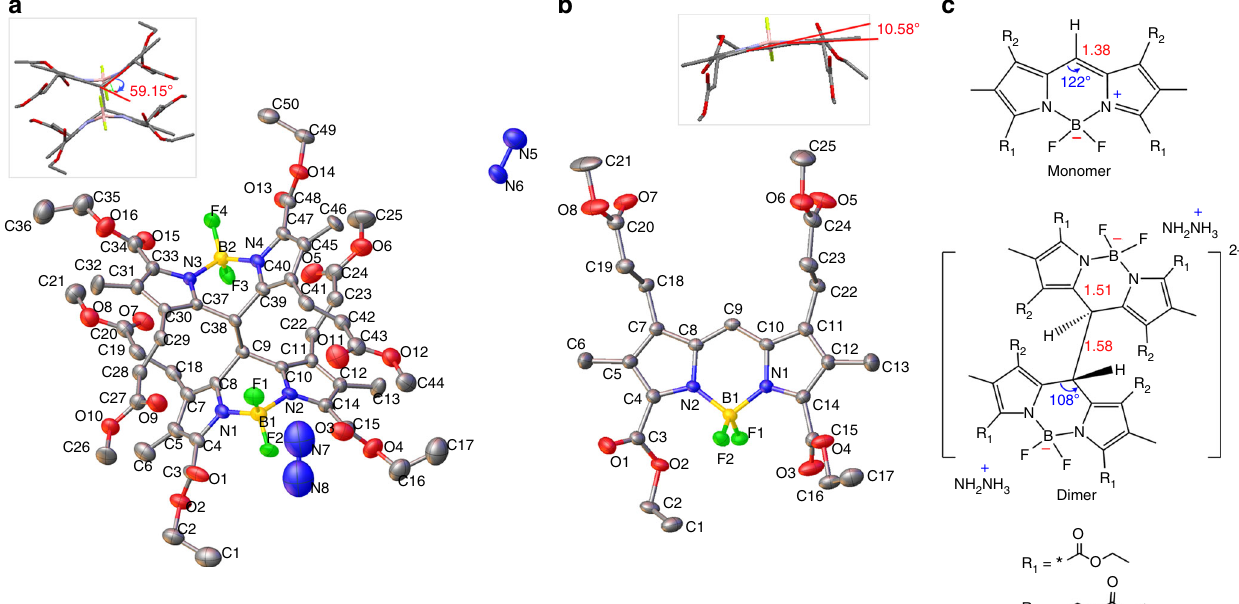
Fig. 3 Crystal structures of dimer and monomer of 1 . a Colorless D1 and b red 1 with thermal ellipsoids at the 50% probability level. Atom numbering schemes are shown; the hydrogen atoms are omitted for clarity. c The molecular structures of monomer and dimer with critical bond lengths (red) and angles (blue) denoted